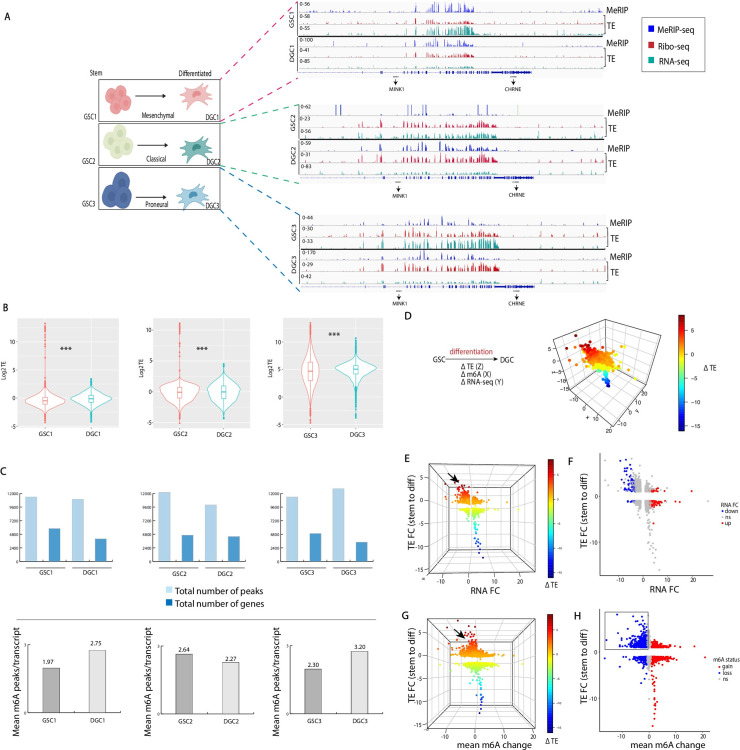
Translation, methylation and transcriptome profile of GSCs and differentiated progenies.A) MeRIP-seq and RNA-seq normalized Ribo-seq peak profiles representative GSCs subtypes (mesenchymal, classical and proneural) and differentiated progenies (DGCs) (GSC, n = 3; DGC, n = 3). Specific sequence region shown for illustration of peaks profile across cells. B) Median translation efficiency for GSCs and differentiated progenies. Translation efficiency (TE) derived from the base-2 logarithm of the ratio of mRNA expression levels in the polysome fraction to that of total mRNA per transcript (***p<0.001 for GSCs to DGCs1/2/3, Wilcoxon test). C) Quantification of number of peaks in GSCs and DGCs per subtype. Upper panel shows total number of peaks and associated number of genes per sample; lower panel indicates average peak per transcript in GSCs and corresponding DGCs. D) Change in methylation, m6A and TE following differentiation shown in 3D plot and gradient intensity represent degree of TE FC; z-axis = TE FC, x-axis = mean m6A change, y-axis = RNA-seq FC. E) Plot rotated along RNA FC and TE FC axes, black arrow indicates region with highest TE FC (gradient intensity represent degree of TE FC; z-axis = TE FC, x-axis = mean m6A change, y-axis = RNA-seq FC). F) 2D scatterplot along the RNA FC and TE FC plane axes which emphasizes upregulated (red, 102 genes) and downregulated subset of genes (blue, 120 genes) following GSCs to DGCs differentiation (P <0.05, FC = 2). G) Plot rotated along mean m6A change and TE FC axes, black arrow indicates region with highest TE FC (gradient intensity represent degree of TE FC; z-axis = TE FC, x-axis = mean m6A change, y-axis = RNA-seq FC). H) 2D scatterplot along the mean m6A change and TE FC axes shows transcripts demarcated by average gain and loss of m6A; cut-off of 1 ≤ and -1 ≥ respectively.